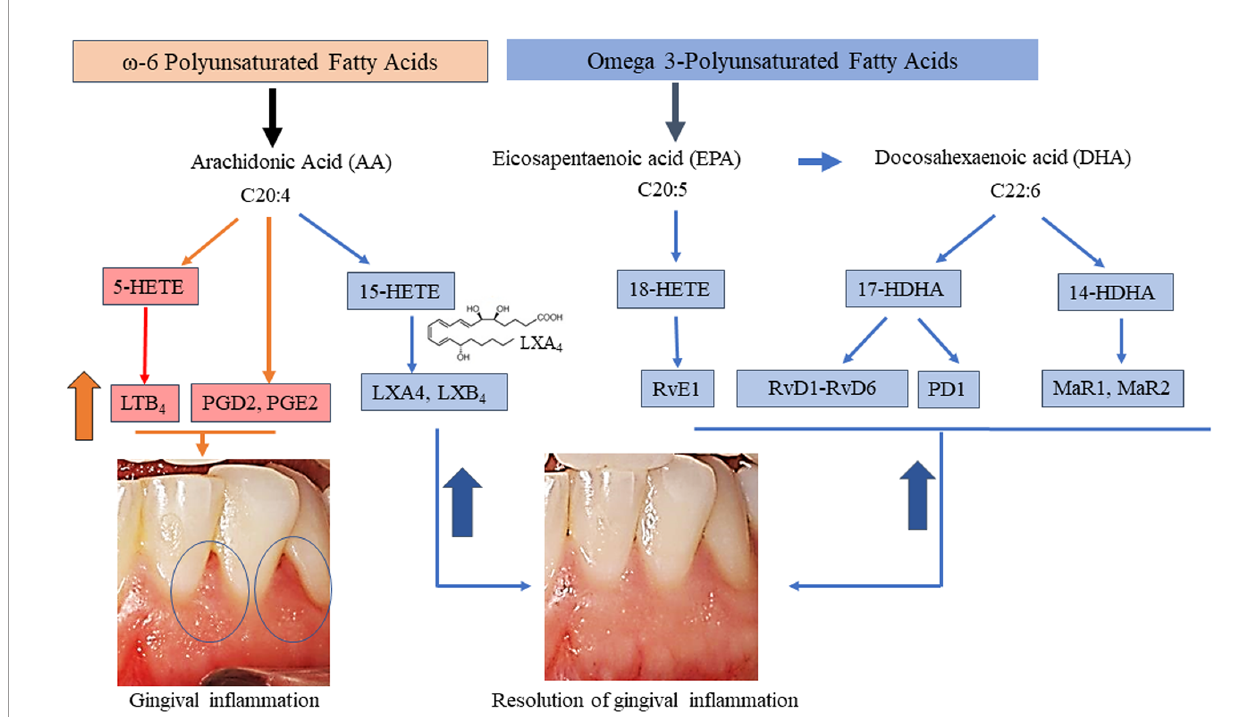
FIGURE 5 | Overview of pathways of targeted eicosanoids and specialized pro-resolving mediators and resolution of gingival in fl ammation. Each are derived from three PUFA namely AA, EPA, and DHA with known biological functions of the pro-in fl ammatory mediators involved in the initiation of in fl ammation and of those involved in the resolution of in fl ammation are included. Mediators whose serum levels increased during in fl ammation (orange arrow and pink boxes) and during resolution of in fl ammation (blue arrow) following BLXA4 treatment on Day 28 are shown in blue shaded boxes, respectively.